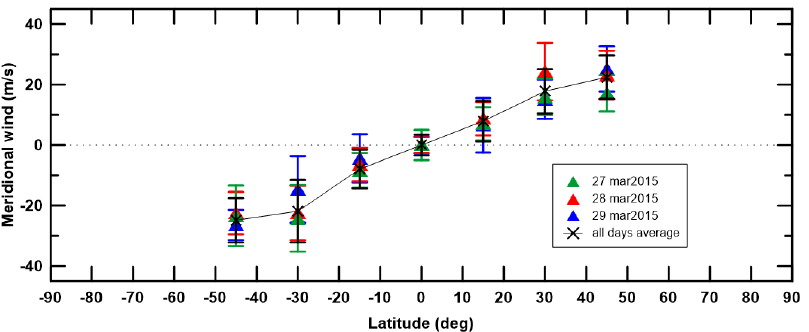
Figure 4. Latitudinal profile of meridional wind for each day of observation. For each day, we applied a weighted average on all the Doppler values at each latitude, producing a daily latitudinal profile of the meridional